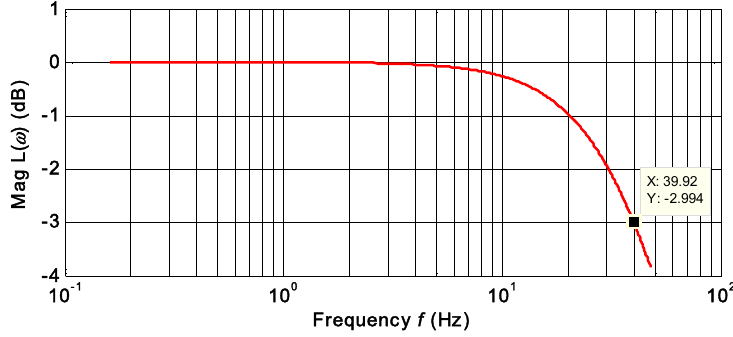
√ q ω = 11,500 ◦ /h . Figure 11. Plot of the frequency response of KF for =11,500 / h q ° . ω